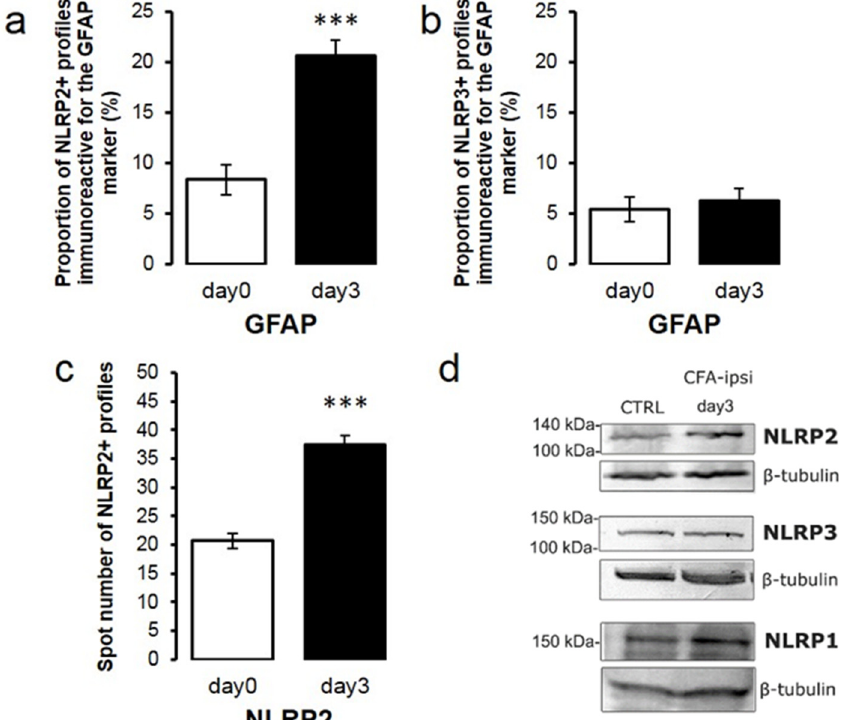
Figure 6. Astrocytic NLRP2 expression, but not NLRP3, is significantly increased during CFA-evoked inflammatory pain. ( a ) Histogram shows that the CFA-evoked inflammation induced an increase in the degree of co-localization between GFAP and NLRP2 markers in the superficial spinal dorsal horn of rats. Columns indicate the percentage of GFAP profiles that were found to also be labeled with NLRP2. White column shows data obtained from control animals (day 0), whereas the black column represents values found in CFA-injected animals 3 days after CFA injection into the right hind paw (day 3). CFA-evoked inflammation significantly increased the proportion of NLRP2 immunoreactive spots on astrocyte profiles ( p = 0.000000148). Data are shown as mean ± SEM. ( b ) Histogram with the same key shows that CFA injection did not cause significant changes in the degree of co-localization between GFAP and NLRP3 markers in the superficial spinal dorsal horn of rats. Data are shown as mean ± SEM. ( c ) Histogram with the same key showing a significant enhancement of NLRP2 immunoreactive spots in chronic inflammatory pain compared to control (100%) ( p = 0.000000111). Data are shown as mean ± SEM. ( d ) Western blot analysis shows substantial increase of NLRP2 protein in tissue lysates of spinal cord 3 days after CFA administration (CFA-ipsi day 3) compared to control (CTRL). NLRP1 and NLRP3 proteins are also detectable in the tissue samples. *** p < 0.001.